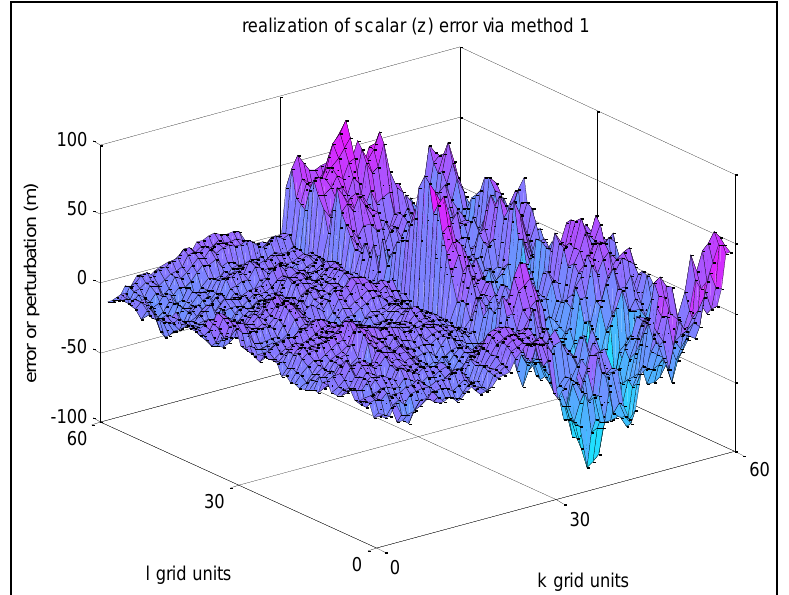
Figure 18. An abrupt transition between Region 1 and Region 2 , each with their own specified a priori